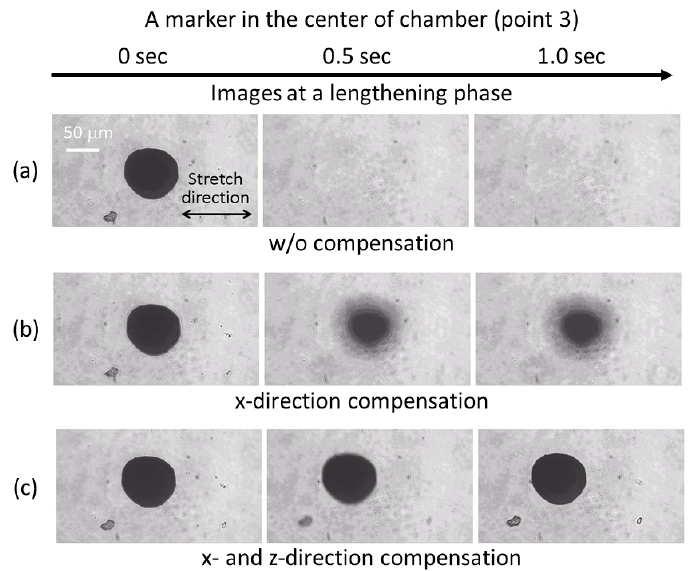
Figure 9. An artificial marker was used in the basic experiments to test the effectiveness of compensation. The diameter of the marker was approximate 50 µ m. Images at the beginning, middle, and end of a lengthening phase are shown from the left to right. ( a ) Chamber stretching by stage 1 only (conventional). ( b ) Chamber stretching by stage 1 with compensation in the horizontal direction by stage 2. ( c ) Stretching by stage 1 and compensation in horizontal (stage 2) and vertical direction (stage